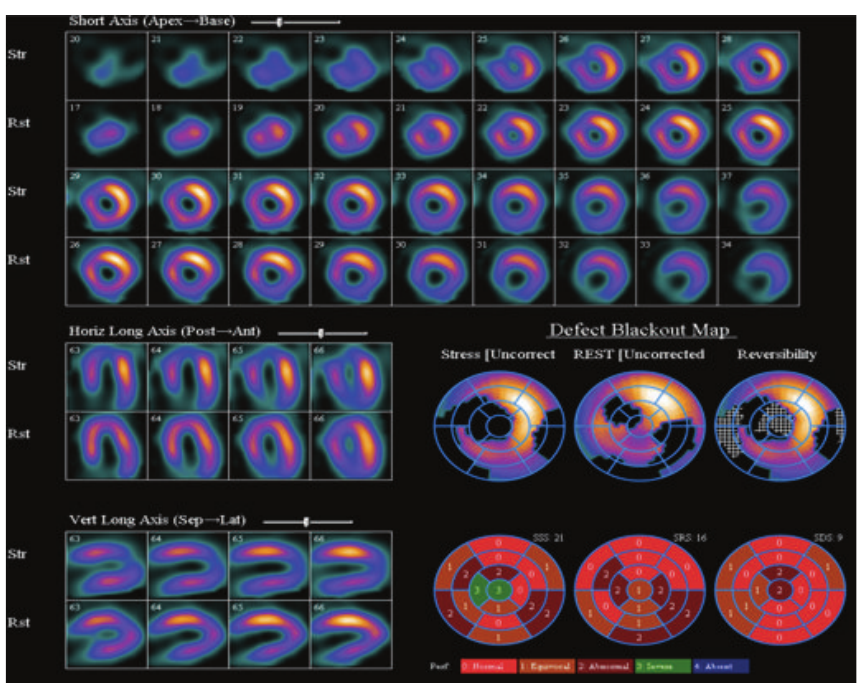
Figure 6: Myocardial perfusion imaging demonstrating a moderate size area of ischemia in the mid to apical anteroseptal, apical, and periapical segments.